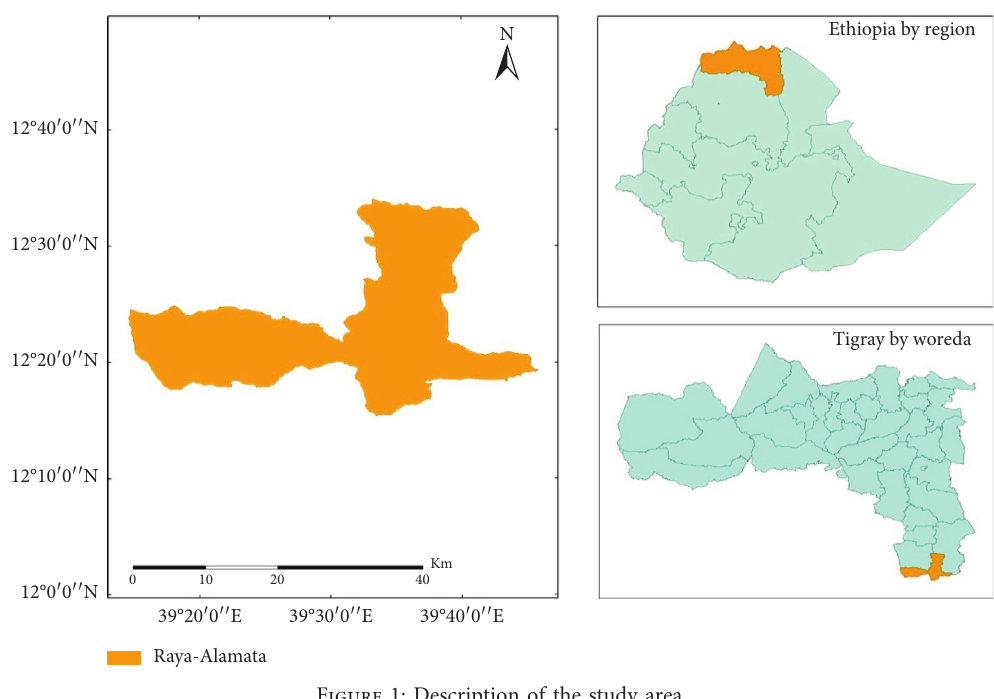
Figure 1: Description of the study area.